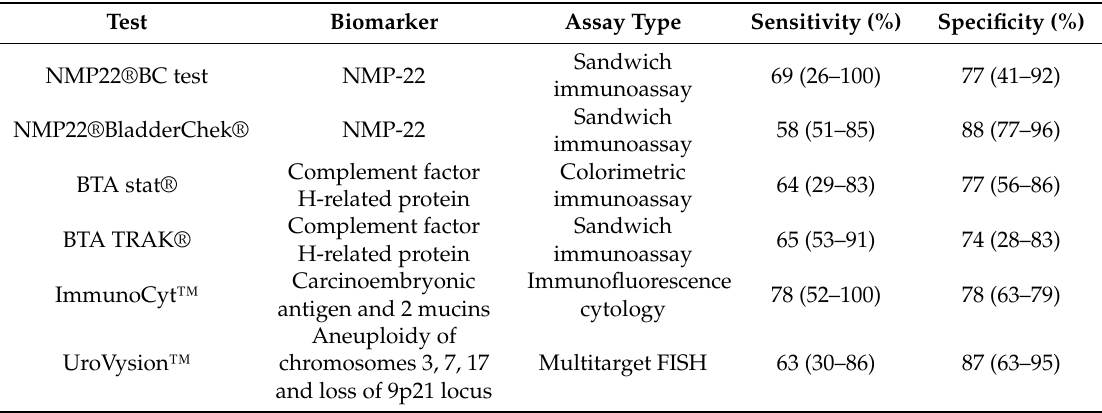
Table 1. Commercially available FDA-approved tests for bladder cancer. The biomarker and assay type of the tests are included in the table. The mean and range (between brackets) of the overall sensitivity and specificity are also shown. Adapted from